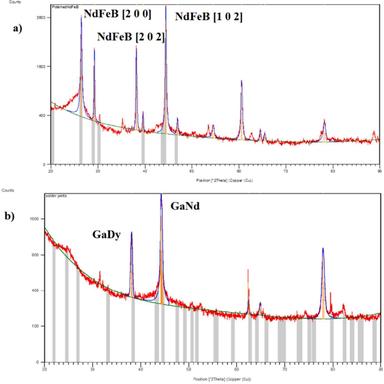
a) XRD analysis result of the magnet specimen showing NdFeB b) XRD results obtained for the solder joint extracted from printed circuit board showing GaNd and GaDy.